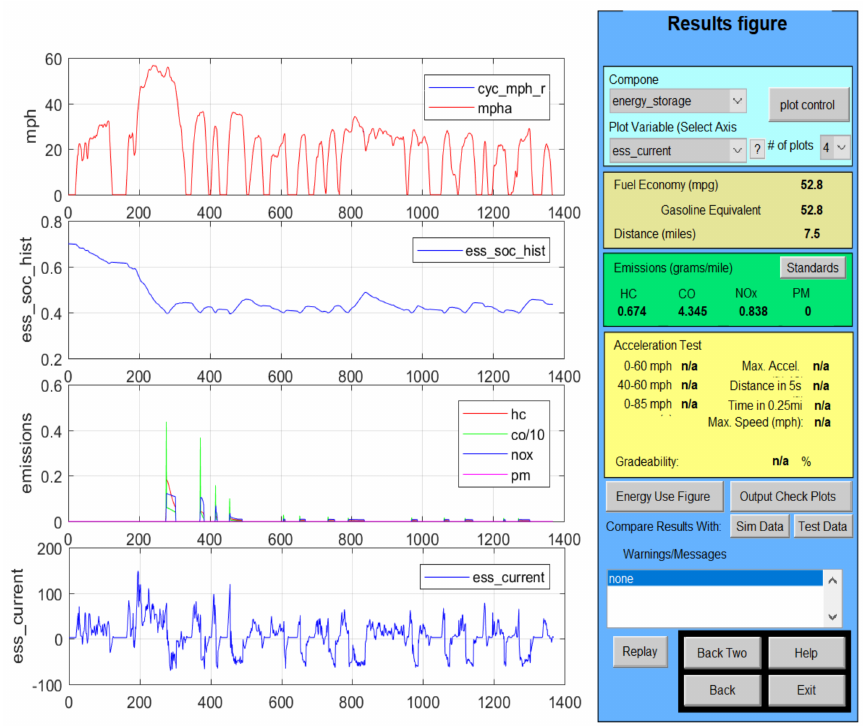
Figure 5. The performance results for a driving FTP-75 cycle followed by HWFET cycle for a HEV SMcar in MATLAB environment. In the first top graph, we show the UDDS speed cycle profile, in the second top graph, we show the estimated value of Li-Ion SAFT battery SOC, in the third graph, we show the gas emissions, in the last bottom graph, we show the discharging current UDDS FTP-75 cycle